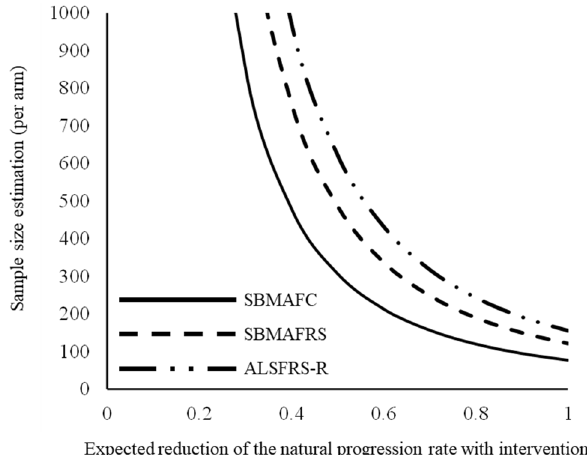
Figure 3. Sample size estimation Sample size estimation performed with the observed variability in score changes for a hypothetical intervention indicated that the responsiveness was better in the SBMAFC than in the existing functional scales, SBMAFRS and